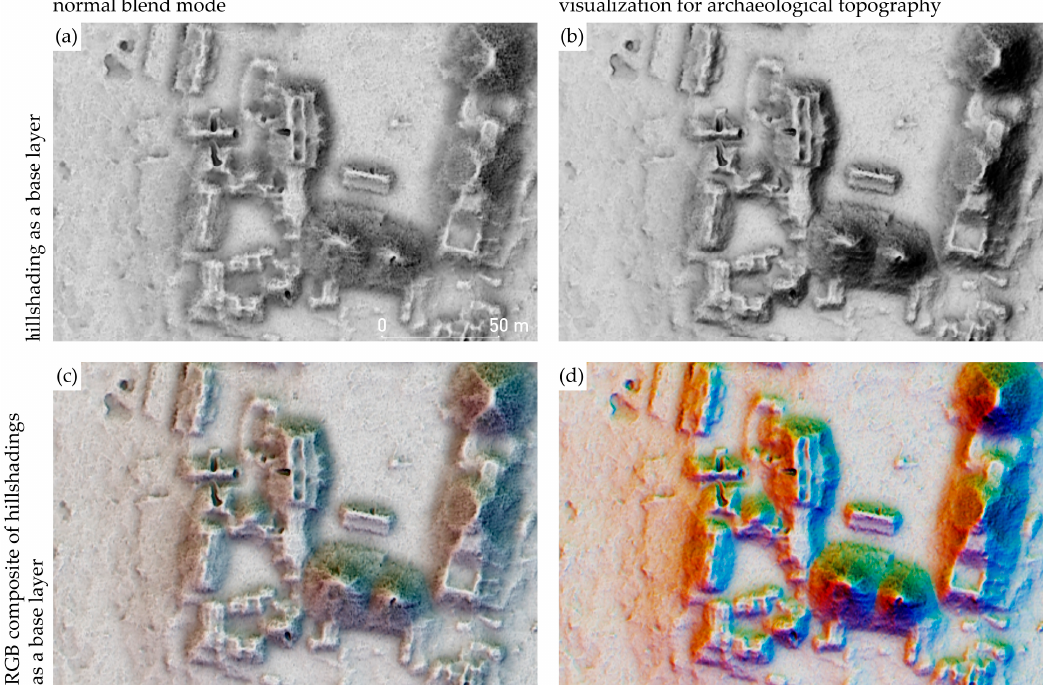
Figure 9. The left column, i.e., plates ( a ) and ( c ), shows two combinations of visualizations based on normal blend mode. The right column, i.e., images ( b ) and ( d ), shows two examples of the visualization for archaeological topography, which is based on blending with different blend modes. The opacity of the layers is the same for all plates. The layers that were combined are sky-view factor, positive openness, slope, and for (a) and (b) hillshading, while for (c) and (d) an RGB composite image of hillshading from three directions. Plates (b) and (d) use the same blend modes as used in Figure 7h.